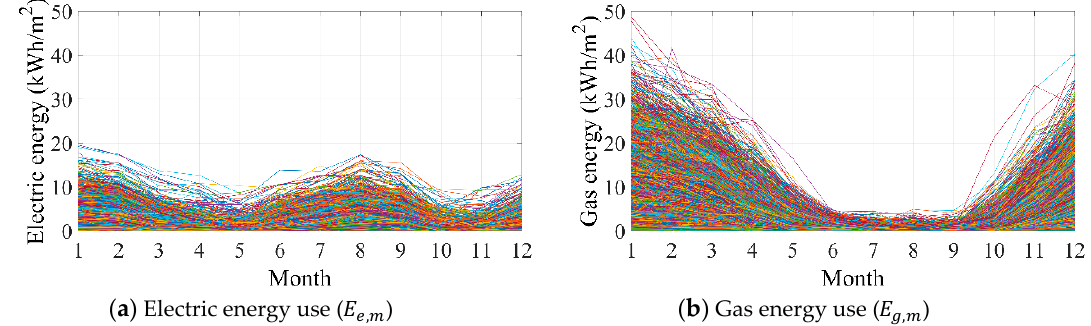
Figure 5. Monthly energy use analysis and categorization of building age and chilling system. The subscript m represents the month (January to December) from 1 to 12.